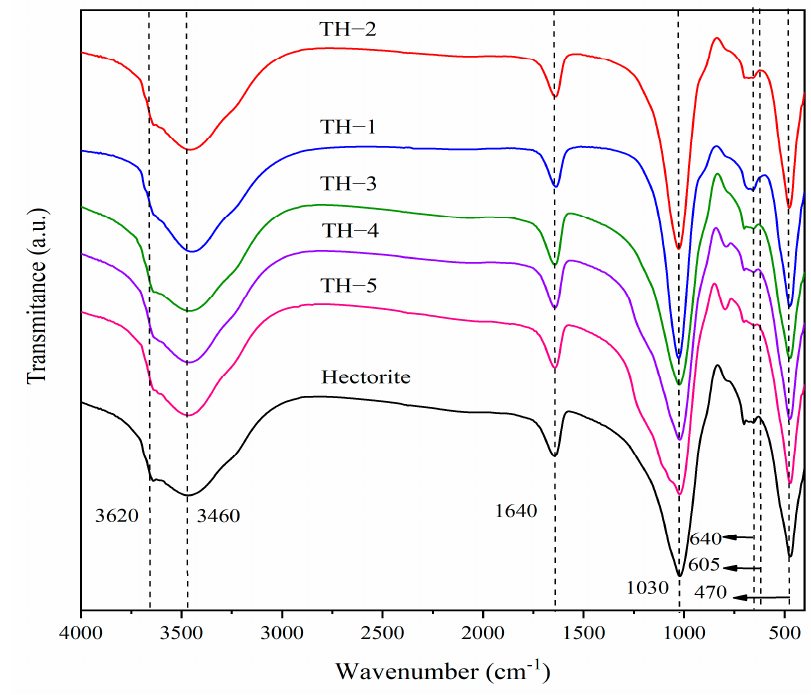
Figure 2. FTIR spectra for hectorite, TH-1, TH-2, TH-3, TH-4, and TH-5.